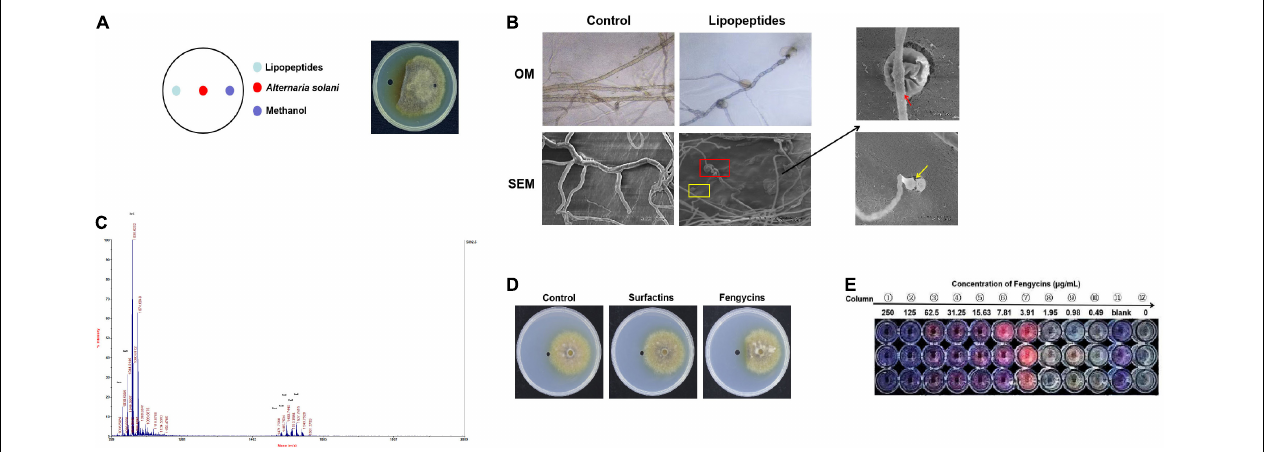
FIGURE 4 | Lipopeptides produced by ZD01 show antagonistic effects against the growth of A. solani HWC-168. (A) Colony morphology of A. solani co-cultured with ZD01 lipopeptides. (B) Optical and scanning electron micrographs of A. solani co-cultured with ZD01 lipopeptides. (C) Identification of ZD01 lipopeptides by MALDI-TOF-MS. (D) Colony morphology of A. solani co-cultured with fengycins and surfactins for the analysis of the active ingredients against A. solani . (E) Determination of the MIC value of fengycins against A. solani using the microdilution method. The red arrows indicate wrinkled surfaces hyphal cells treated with lipopeptides; the yellow arrows indicate the vacuolation of hyphae after exposure to lipopeptides.